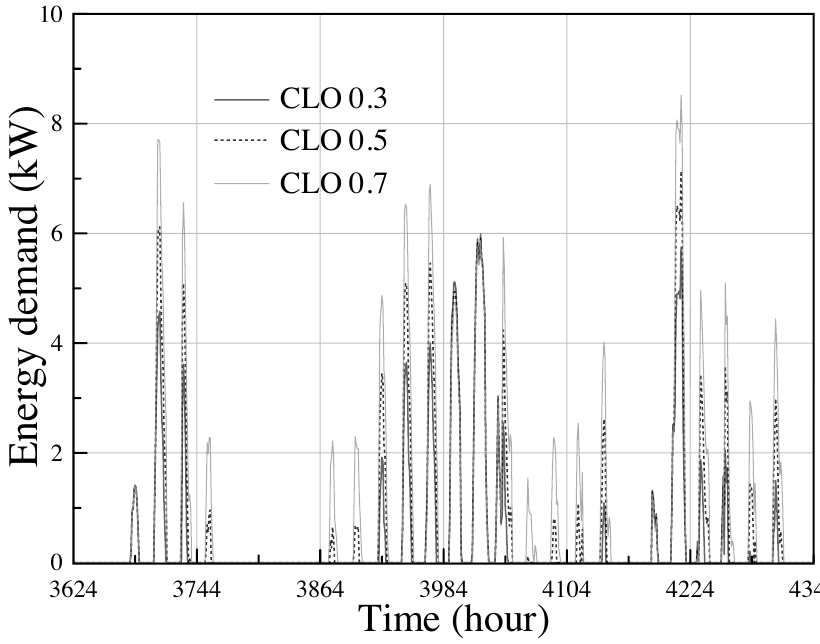
Figure 10. Energy demand for several values of clothing factor. Table 7. Cumulated energy demand between June and September, with varying values of clo and met, for different set temperatures based on the categories of thermal